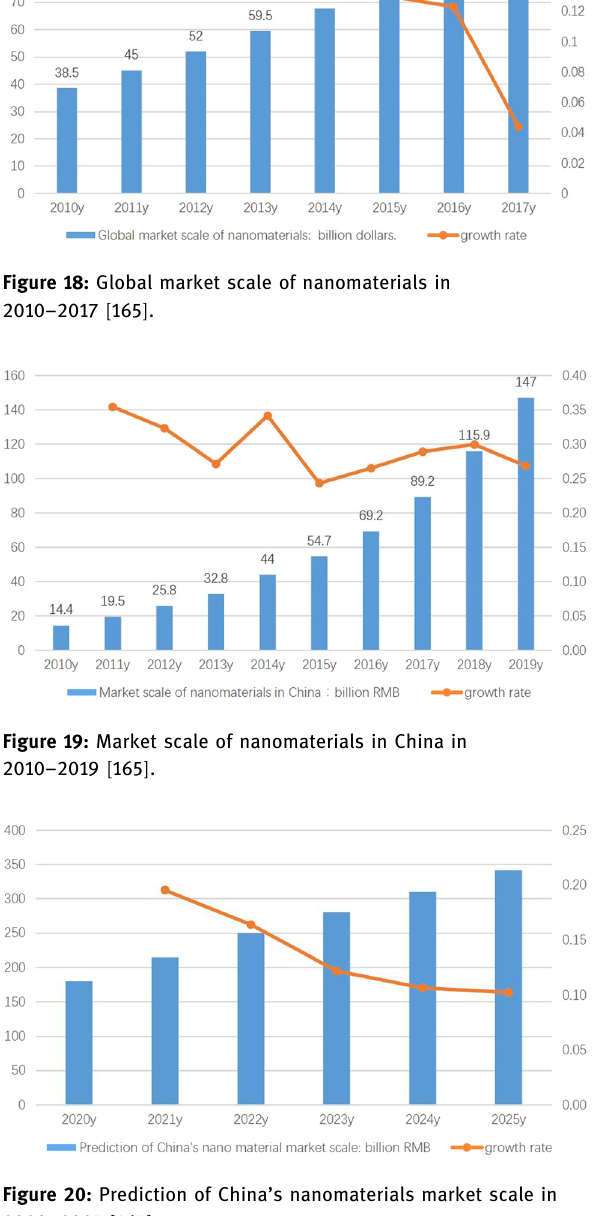
Figure 20: Prediction of China ’ s nanomaterials market scale in 2020 – 2025 [ 165 ]